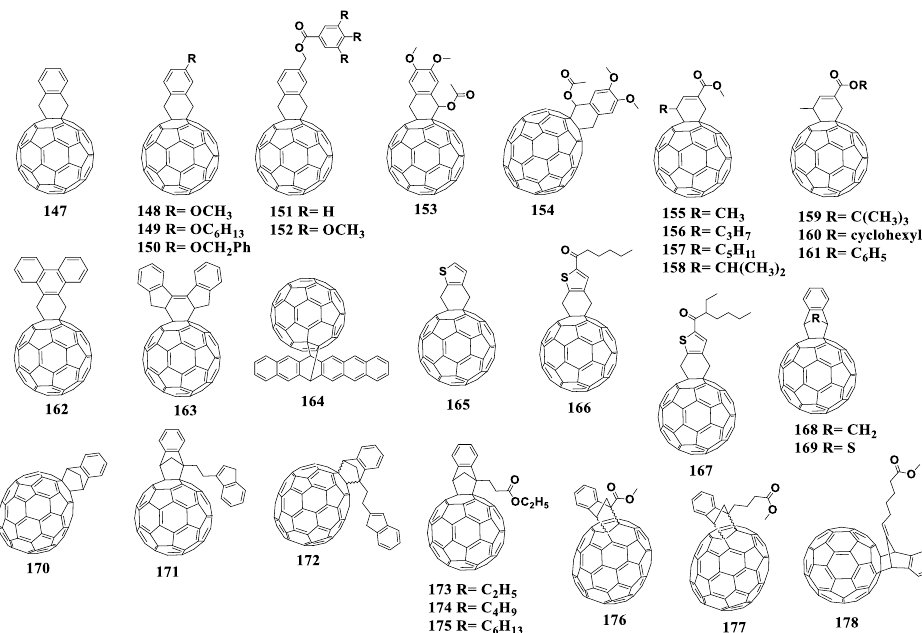
Figure 16. Molecular structures of the fullerene derivatives with reduced electron affinity containing the cyclohexene fragment annelated to the fullerene cage. the cyclohexene fragment annelated to the fullerene